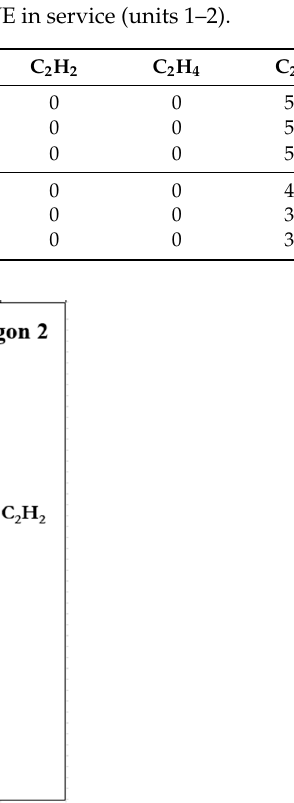
Figure 3. SG patterns of DDB oil in bushings of RWE in service (units 1–2).